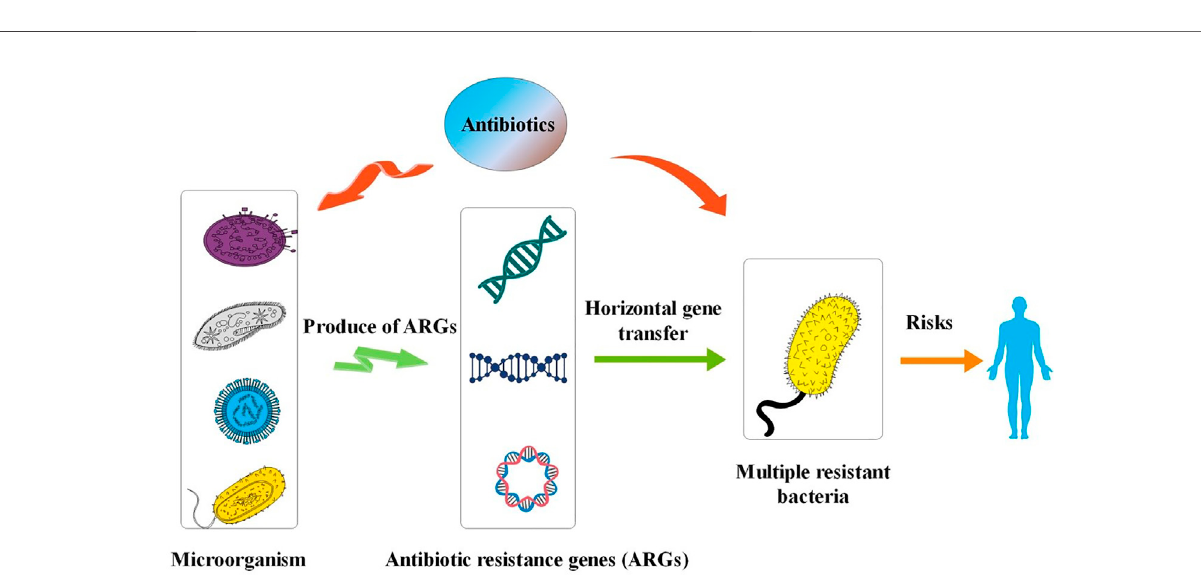
Frontiers in Environmental Science |